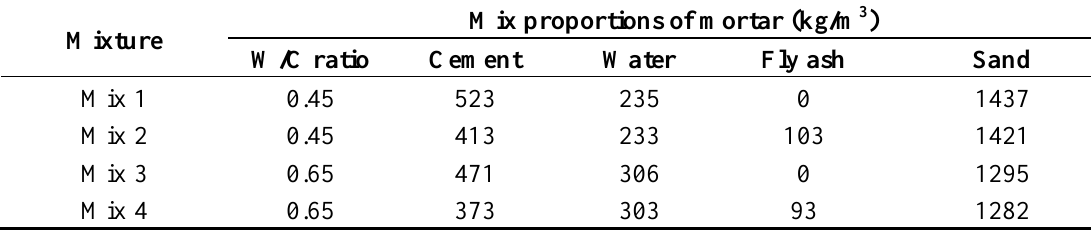
Table 2. Mix proportions of